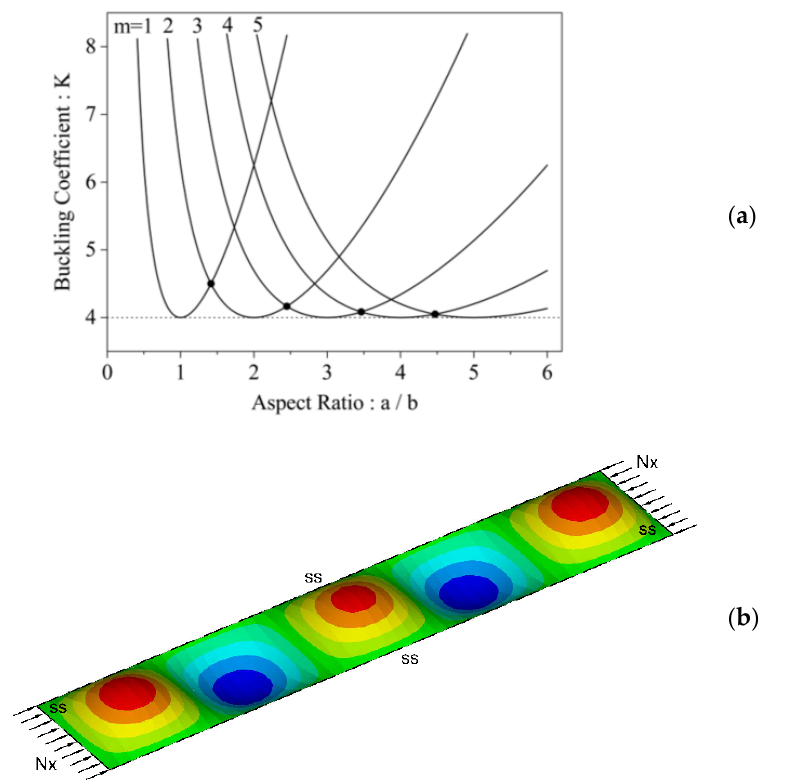
Figure 7. ( a ) Critical compressive buckling coefficient with respect to an increasing aspect ratio and ( b ) the first eigenform of a long plate with aspect ratio equal to 5.